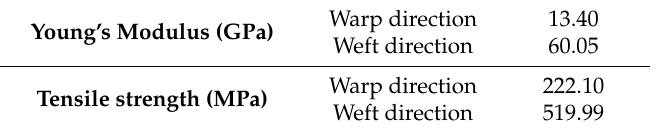
Table 8. Mechanical properties of single-ply conventional TTAI reinforced composite P1C.